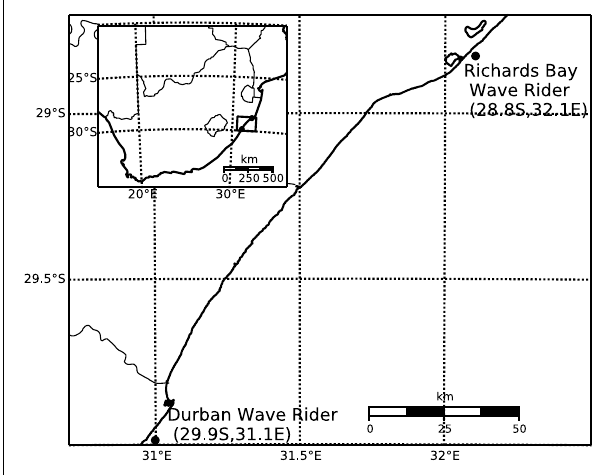
FIGURE 4 | Locations of the wave observation buoys at Durban and Richards Bay, along the KwaZulu Natal